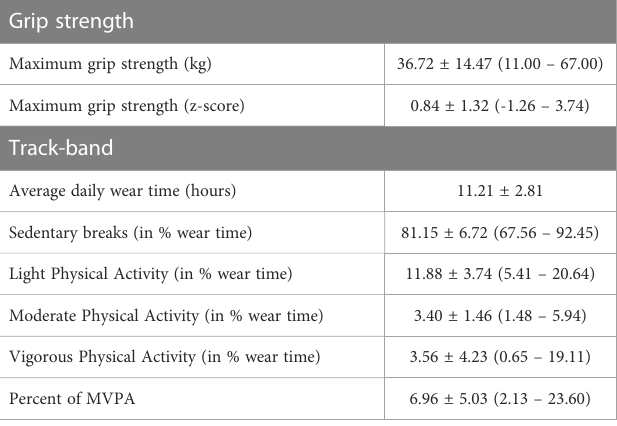
TABLE 2 Grip strength and Track-band results of 18 participants with KS. TABLE 3 Cardiopulmonary Exercise Test results of 18 participants with